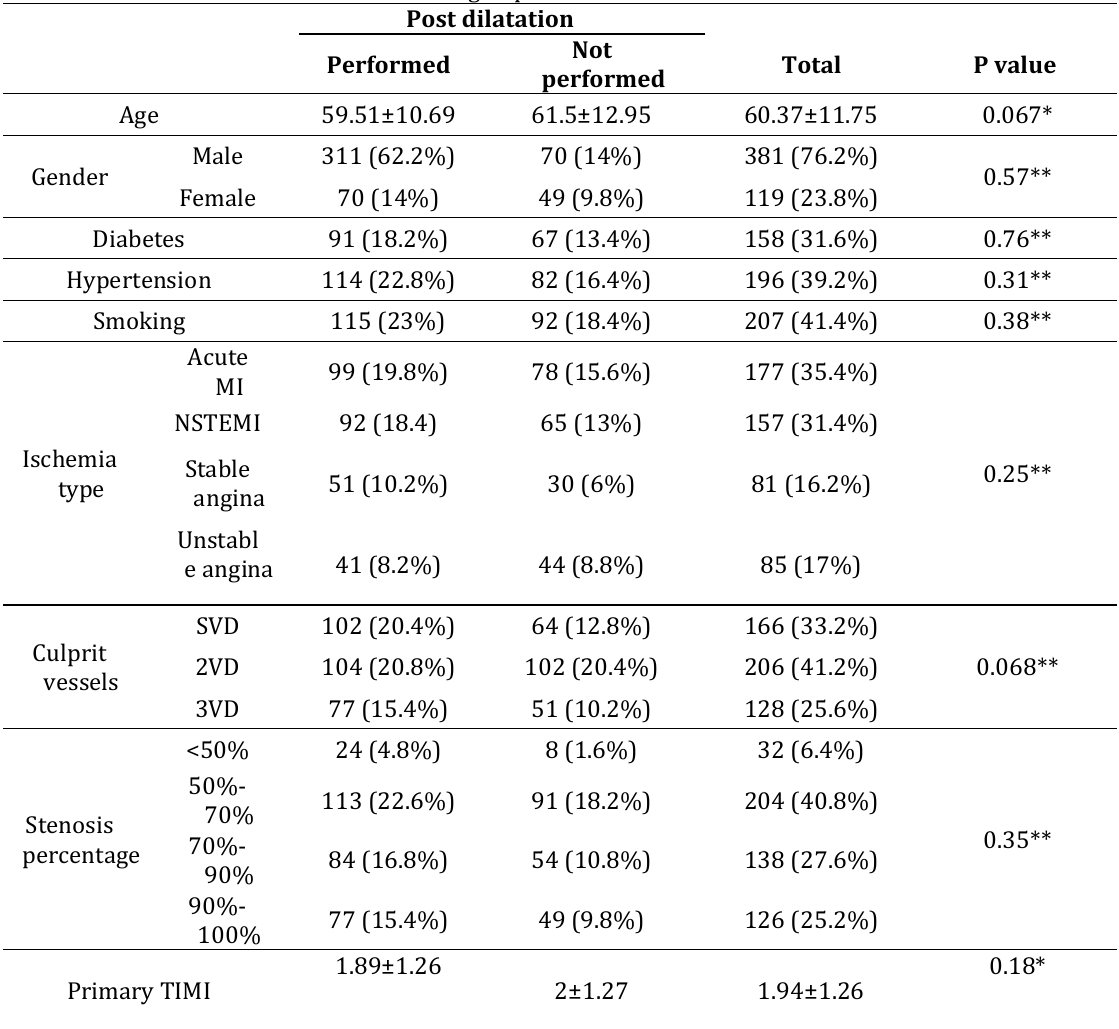
Table 1. Patients’ characteristics according to post dilatation intervention Post